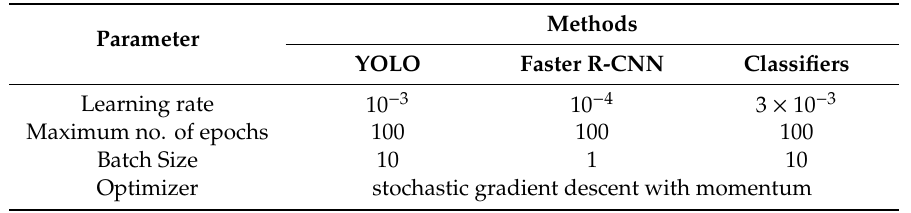
Table 4. Training parameters of head detectors.